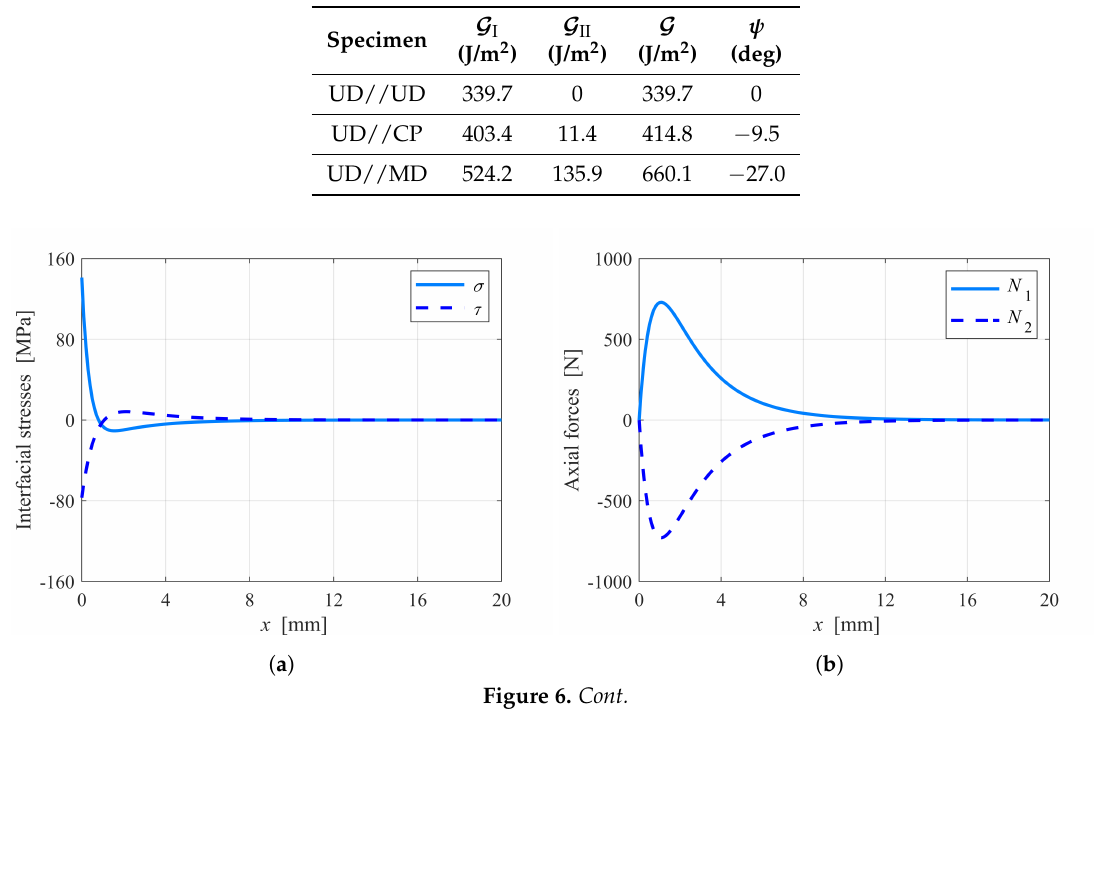
Table 5. Energy release rate and mode mixity.